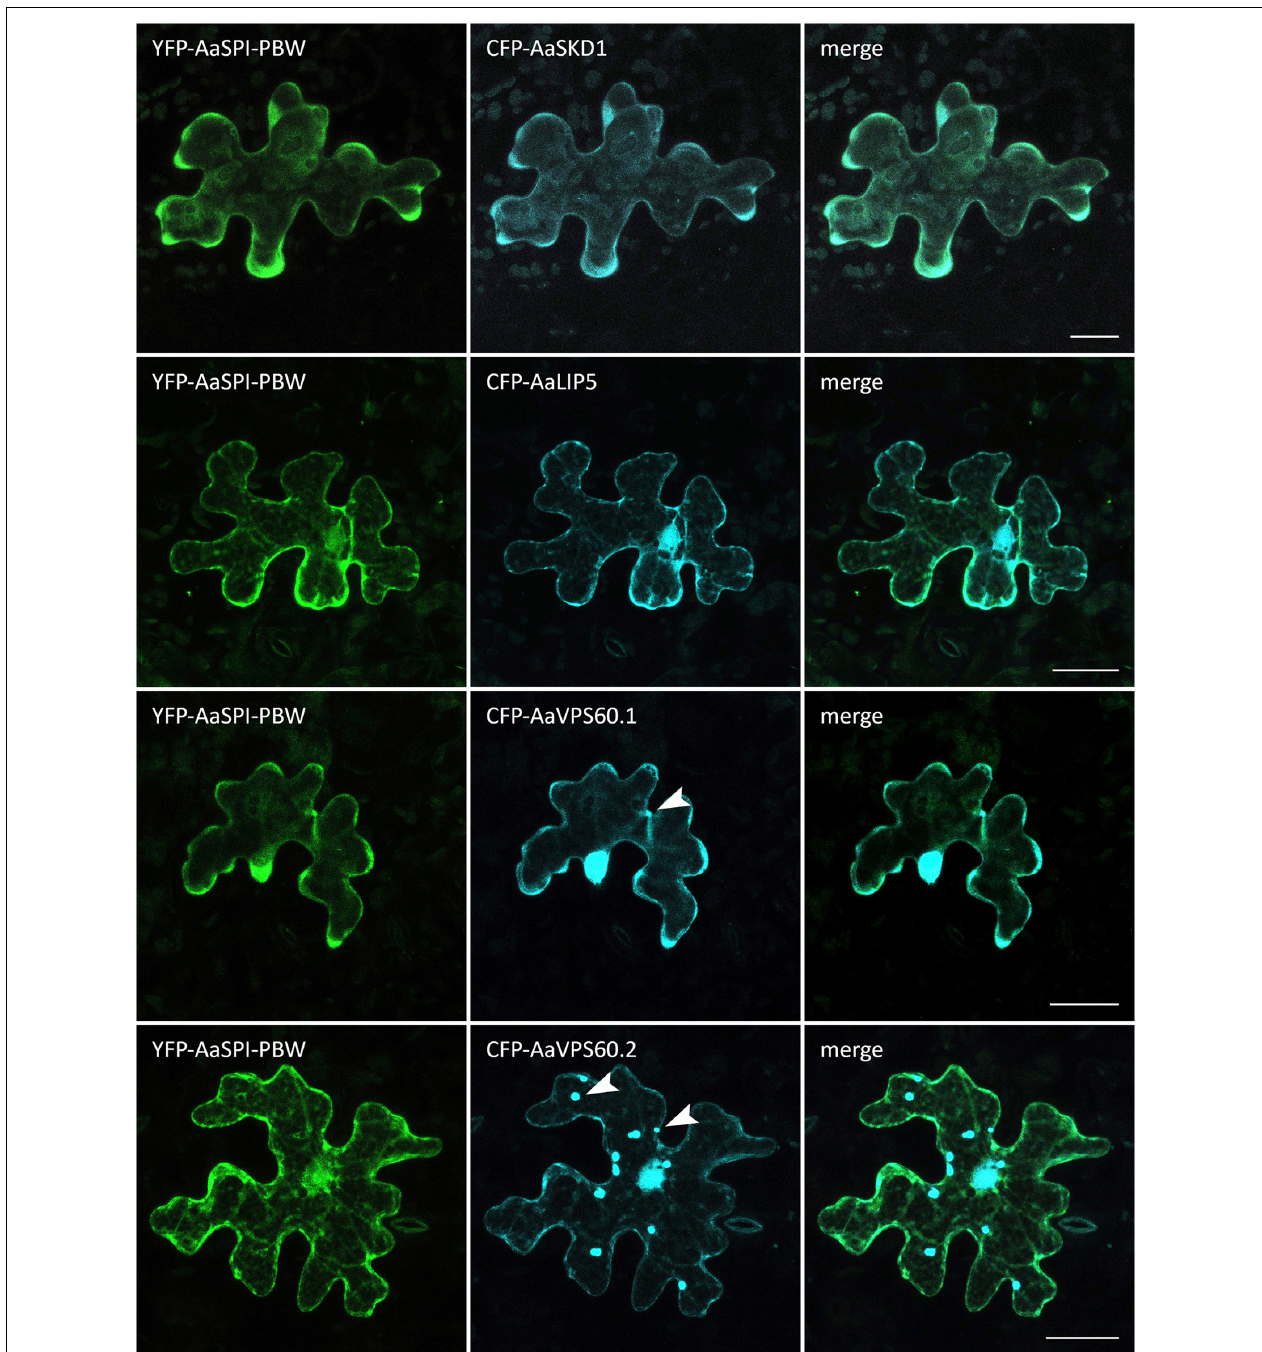
FIGURE 4 | Intracellular localization of CFP-AaESCRT components and YFP-AaSPI-PBW. Transiently expressed CFP tagged AaESCRT proteins and YFP-AaSPI-PBW in Arabis alpina epidermal pavement cells. Arrow heads indicate dot-like structures. Scales bars: 25 µ m.